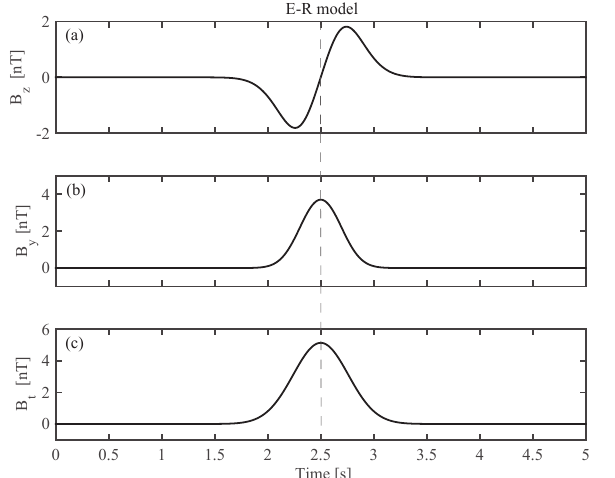
Figure 2. The three variables B z (a) , B y (b) and B t (c) of the ideal cylindrical flux rope described by the E – R model.